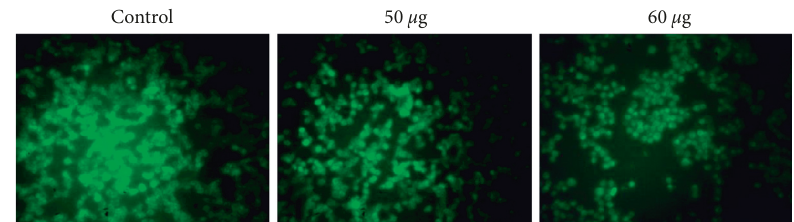
2 -chitosan-farnesol NCs induced ROS level.